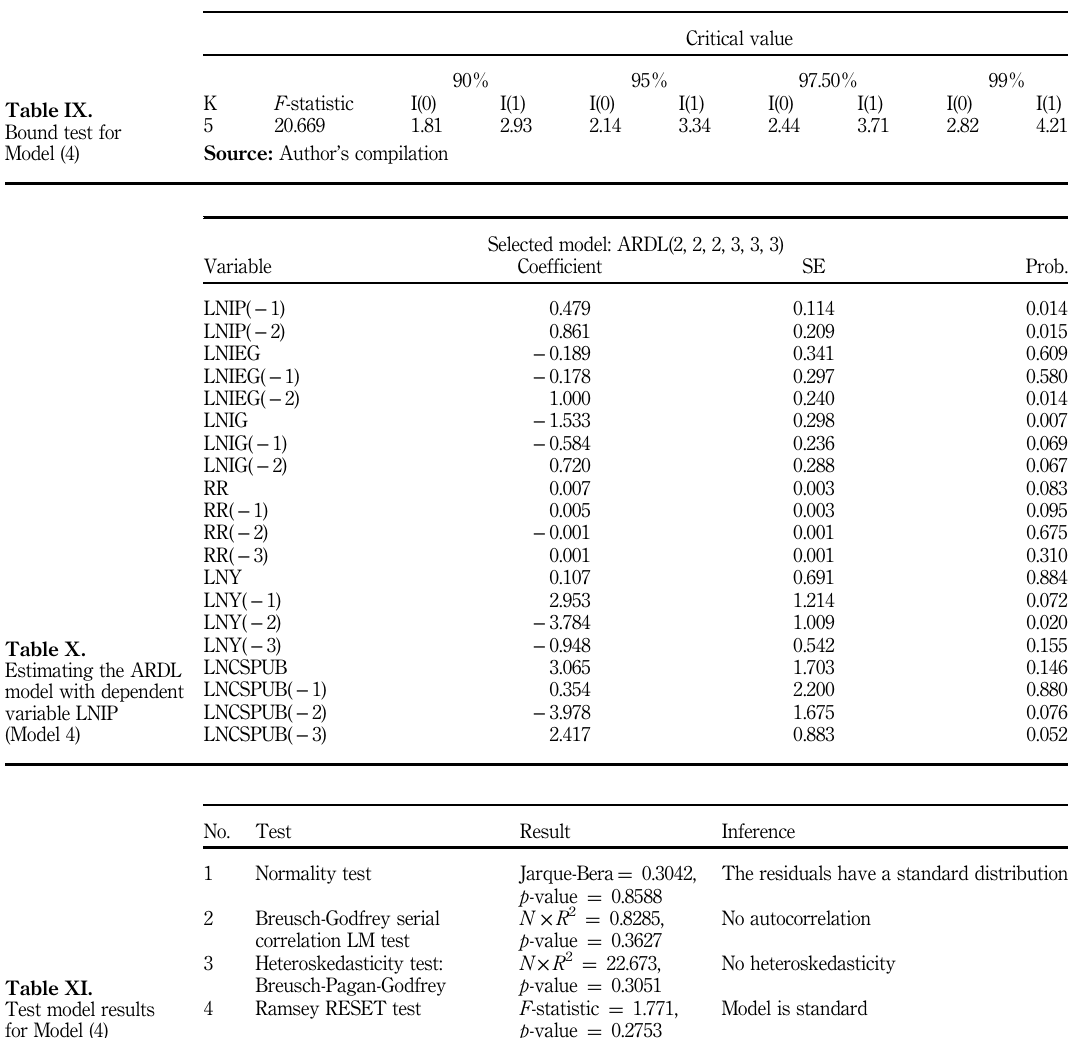
Model is standard